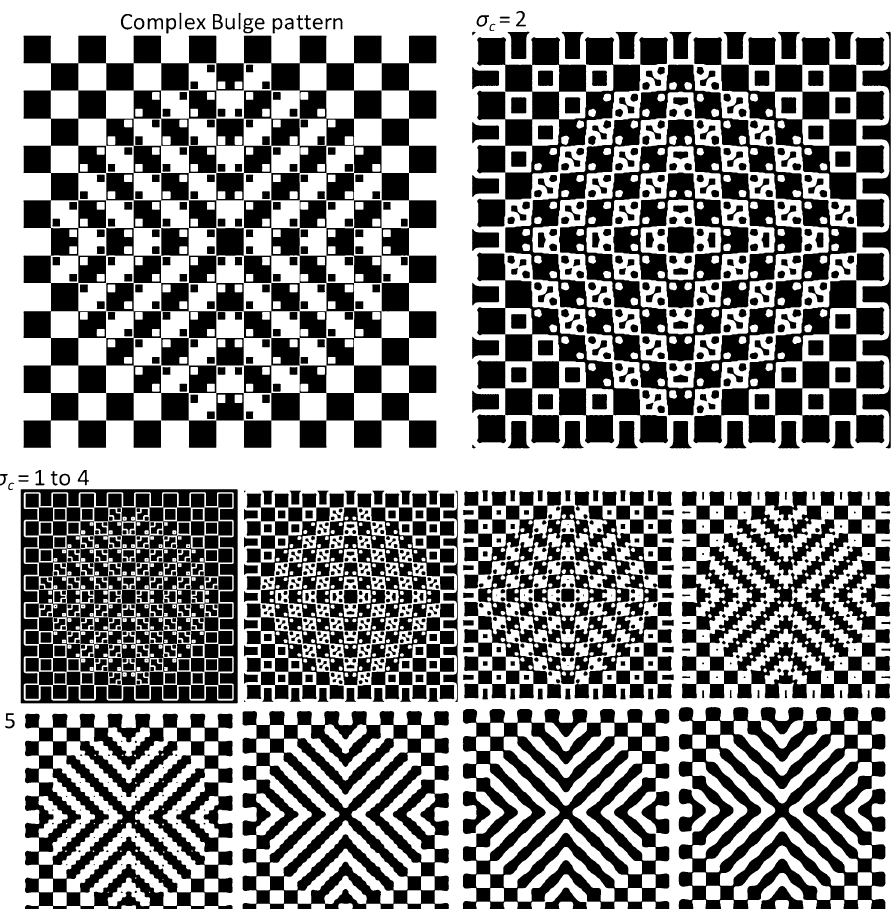
Fig. 6 Top left Complex Bulge pattern (574 9 572 px) and top right The DoG output at scale 2 ( r c ¼ 2)—enlarged that highlights the bulge effect in the pattern. Bottom The binary edge map of the pattern at eight different scales ( r c ¼ 1 to 8) with incremental steps of 1. Other parameters of the DoG model are: s ¼ 1 : 6, and h ¼ 8 (the Surround and Window ratios, respectively) (Reproduced by permission